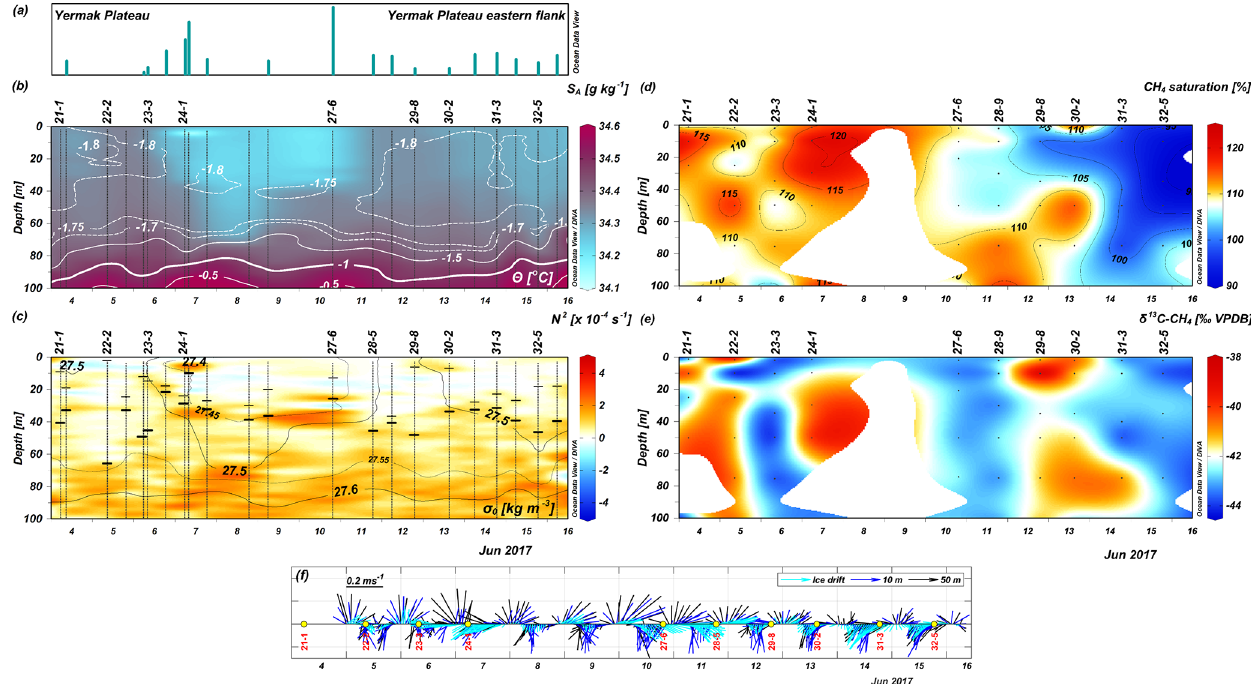
Figure 4. Seawater properties in the upper 100 m along the drift track. The labels on top of panel (b) – (e) denote the CTD stations where methane was sampled in the seawater. Additional CTD casts were used in (a) – (c) as indicated by vertical black lines but otherwise not further presented in this study. (a) Degree of ice melt estimated from the TS profiles (Sect. 3.2). Due to the early melt season, the length scale of the bars was omitted to emphasize the use of this measure only as a qualitative guidance. (b) Absolute salinity (gkg − 1 ) overlaid with isothermals of conservative temperature ( ◦ C). (c) Brunt–Väisälä Frequency (10 − 4 s − 1 ) overlaid with isopycnals of potential density anomaly (kgm − 3 , 0dbar ref. pressure). Positive N 2 values indicate stable stratification. Horizontal black bars show the mixed layer depths estimated for two different density thresholds (upper bar: 0.003kgm − 3 ; lower bar: 0.01kgm − 3 ; see Sect. 3.2). (d) The temporal development of methane saturation (color bar) overlaid with contours of saturation levels and (e) of the δ 13 C signature of methane (‰VPDB). (f) Hourly vectors of the horizontal speed and direction of the ice floe and the underlying waters at 10 and 50m depth, respectively (water velocities unavailable before 5 June). The vector magnitudes follow the length scale in the upper left corner, and north is upward. Yellow dots indicate the methane sampling